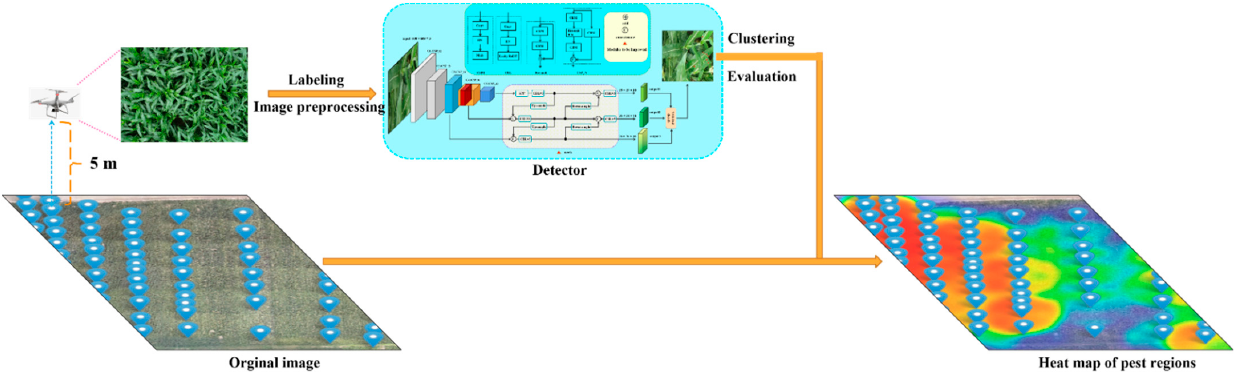
Figure 1. Schematic diagram of the overall technical route of the automatic assessment algorithm for the damage degree of the pest regions.